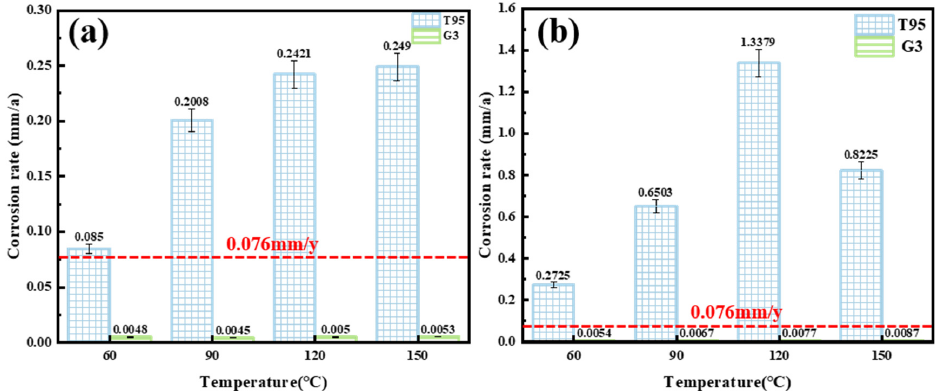
Figure 6. The corrosion rate of tubing in the gas and liquid phase (( a , b ): gas and liquid phase).